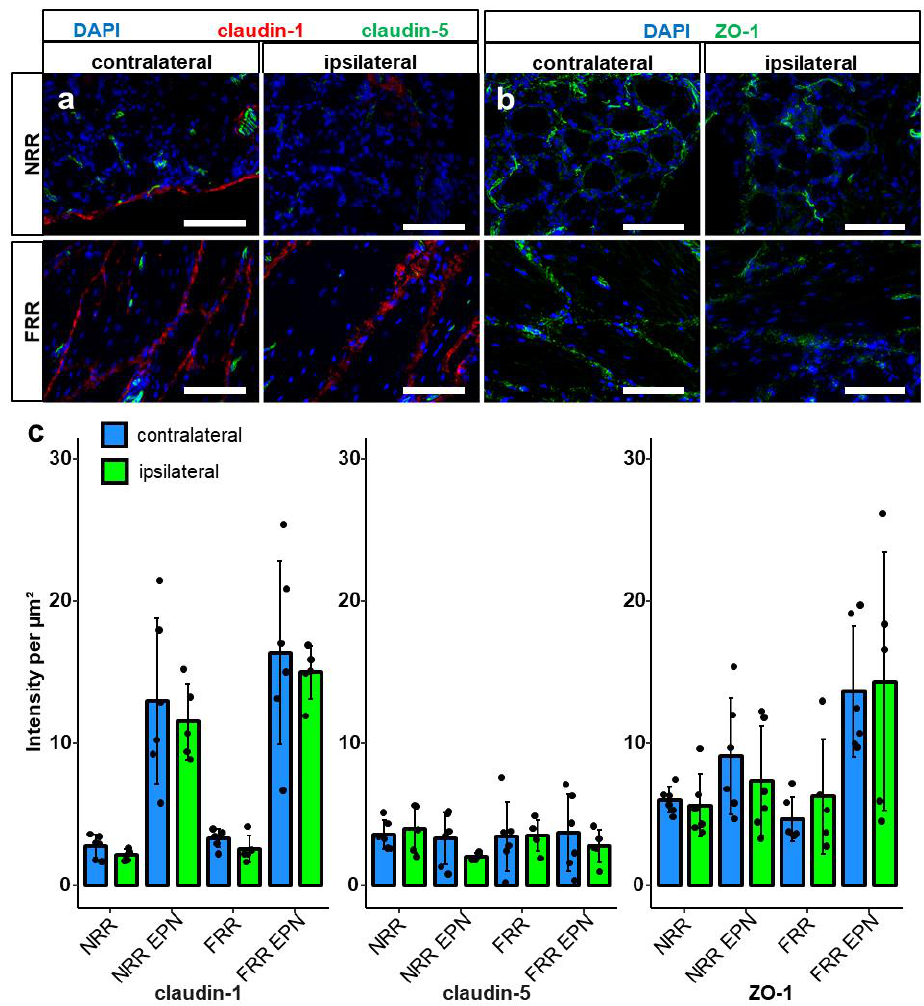
Figure 4. Claudin-1 and ZO-1 IR are unchanged after CCI. DRG sections from Wistar rats with 7 d CCI and naïve controls were immunostained. IRs of claudin-1, claudin-5, and ZO-1 were quantified and compared between IL and CL DRGs after CCI in the neuron rich region (NRR) and fiber rich region (FRR), and their putative EPN are presented as light intensity per µm². Representative sections of claudin-1 (red) and claudin-5 (green) ( a ), and ZO-1 (green) ( b ) are shown. Quantification of the signal intensity in the specified areas: significant differences between regions were not indicated, as they are already analyzed in Figure 1 ( c ). (Scale bars = 100 µm. n = 5 or 6; claudin-1: NRR versus NRR-EPN, NRR versus FRR-EPN, FRR versus NRR-EPN, and FRR versus FRR-EPN: p < 0.0001; ZO-1: FRR-EPN versus NRR: p = 0.0003; FRR-EPN versus NRR-EPN: p = 0.0138; FRR-EPN versus NRR: p = 0.00018. No normal distribution: ZO-1 CL FRR. No variance homogeneity: claudin-1 CL. Two-way ANOVA, Tukey HSD).